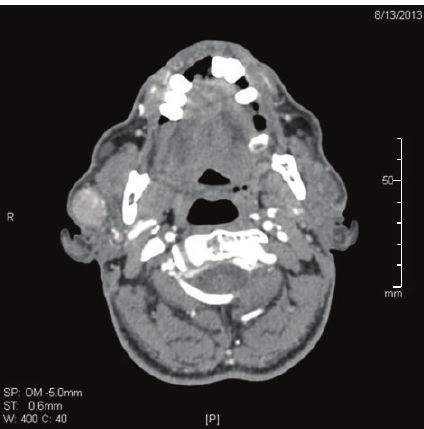
Figure 1: CT neck axial cut, postcontrast, soft tissue window: well- defined oval-shaped mass involving the lobe of the right parotid gland. The lesion shows an increase in density after IV contrast media injection.